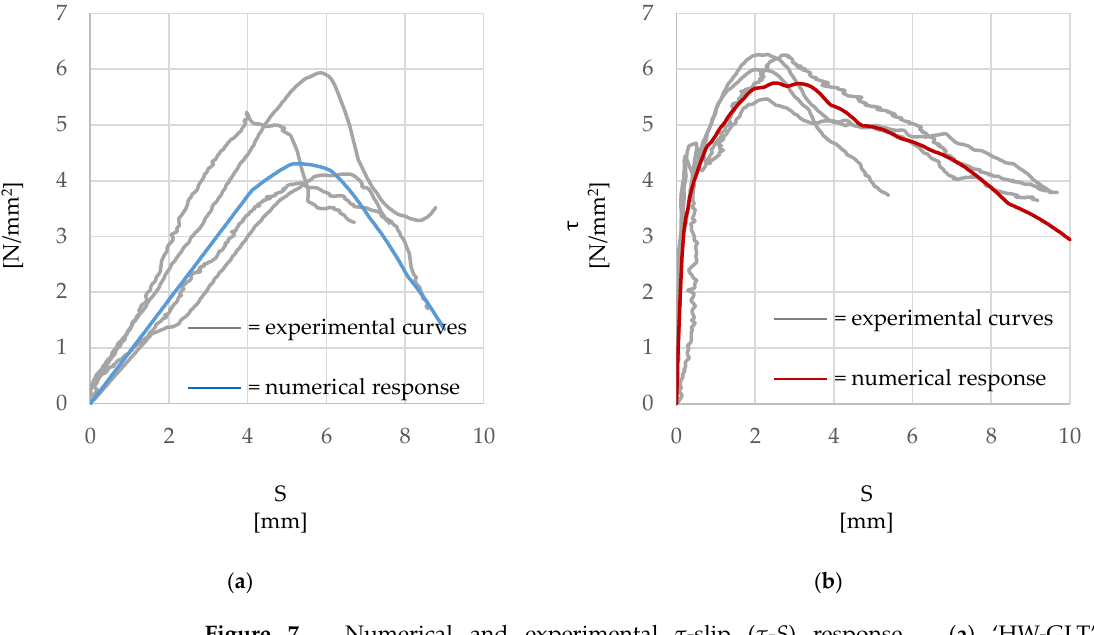
Figure 7. Numerical and experimental τ-slip (τ-S) response. ( a ) ‘HW-GLT’ system; ( b ) ‘HW-GCF’ system.